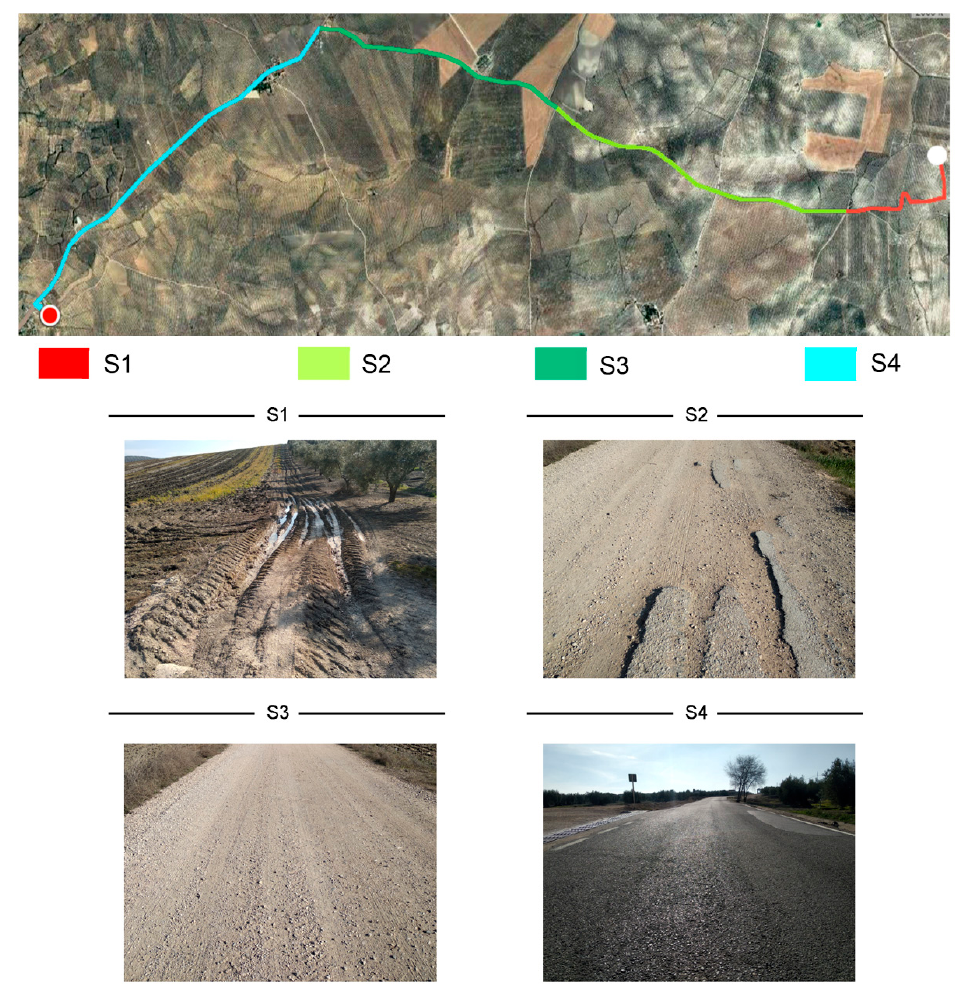
Figure 1. Route selected for field test.